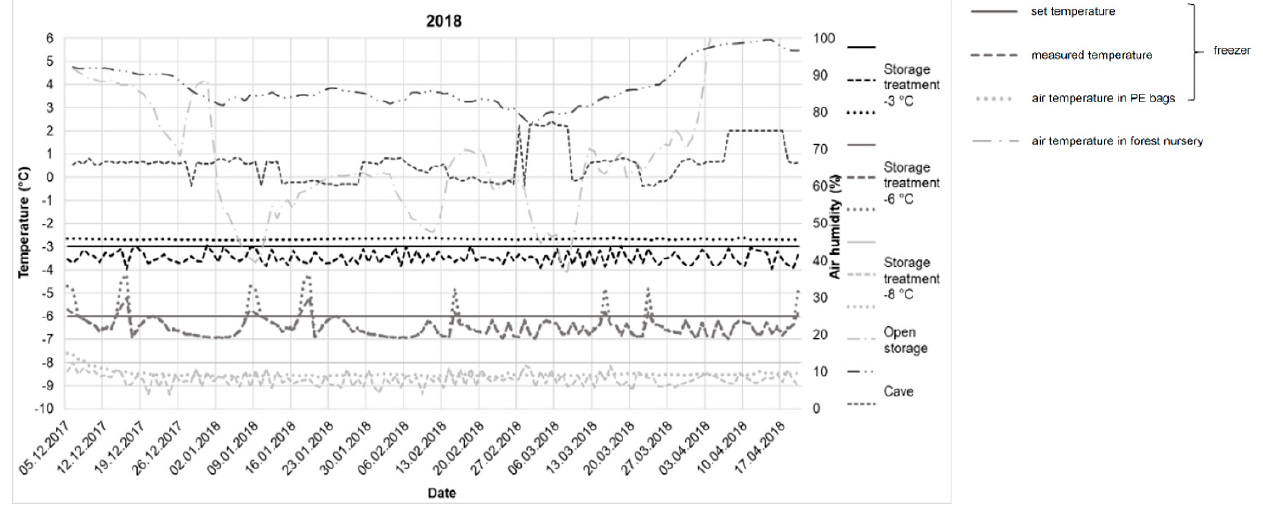
Figure 3. Air temperature during storage of the tested plants in 2018.